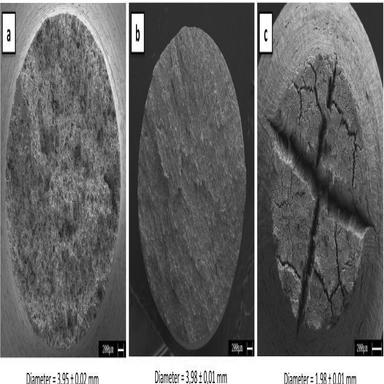
SEM images of specimen fracture surfaces: (a) Vertical – "AM.m.V.1"; (b) Horizontal – "AM.m.H.1"; (c) Plansee bar - "G-A bar.m.1".